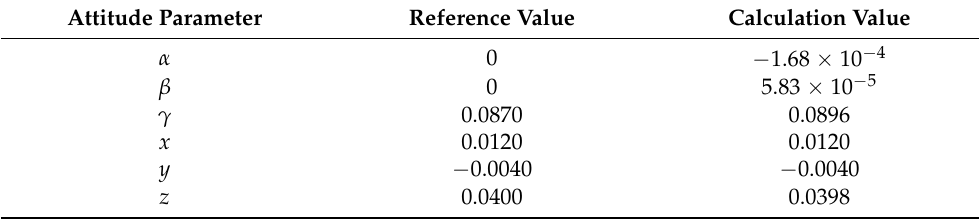
Table 5. Attitude parameter reference value and MPR-NR algorithm calculation